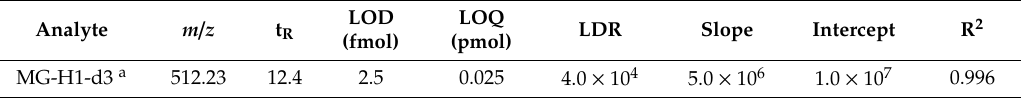
Table 1. Sensitivity and linearity parameters obtained for MG-H1 and reference amino acids.